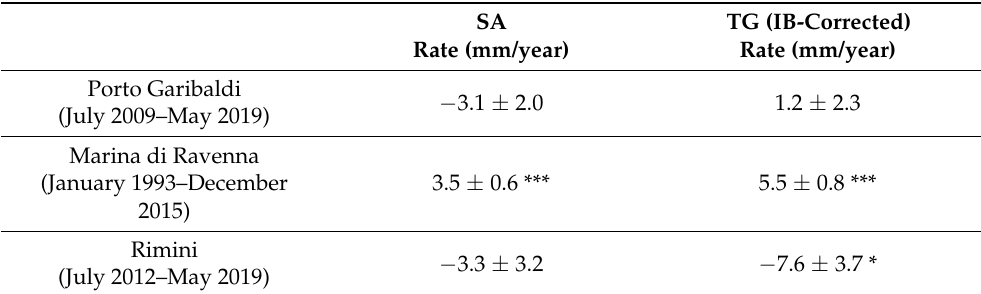
Table 3. Linear trend rate comparison between SA and TG for the common timespan covered. The significance of the resulting trend varies according to the symbol beside each rate